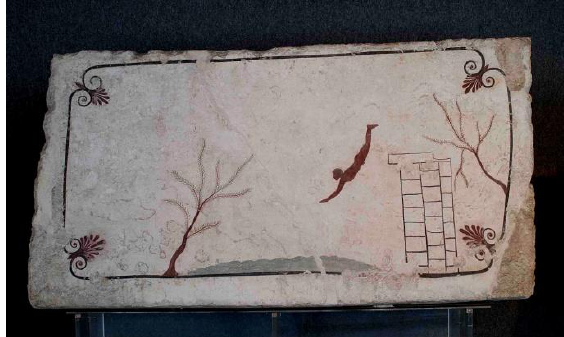
Figure 11. Diver’s Tomb in Paestum